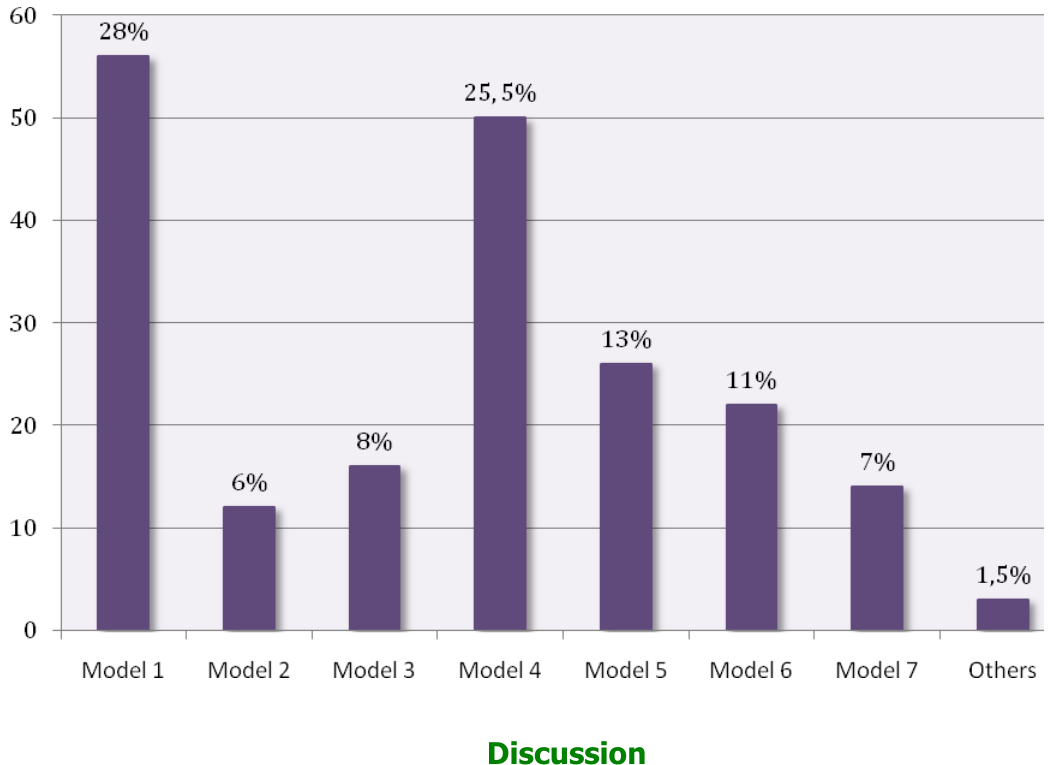
General results: Distribution of